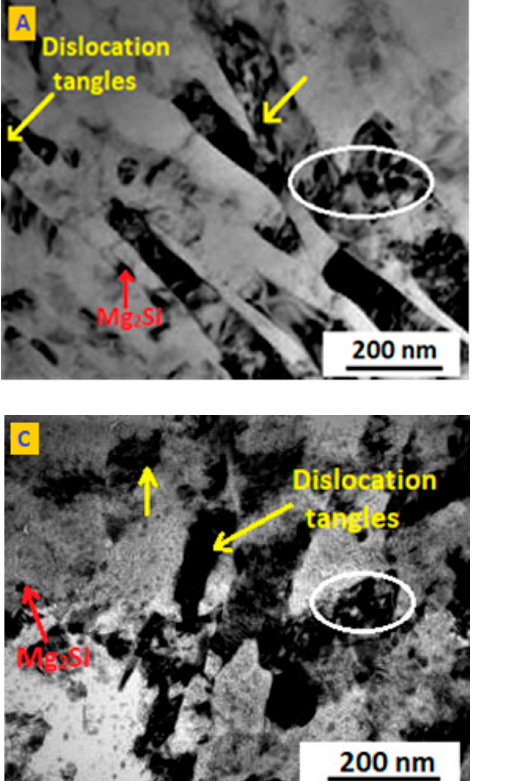
Figure 6. TEM images of Al5083 alloy in ( A ) as-received condition and after the ( B ) 1st pass, ( C ) 2nd pass, and ( D ) 3rd pass.